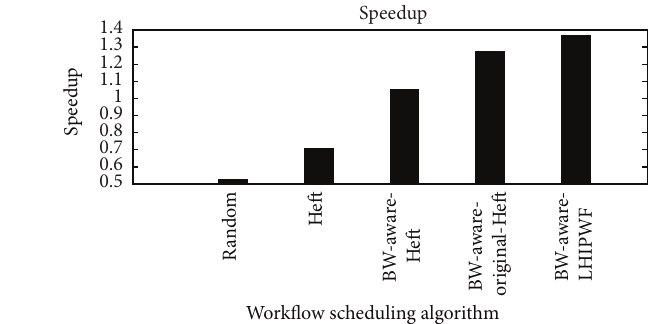
Figure 11: Comparison of the execution time for the workflow of 41 tasks with large data communication.